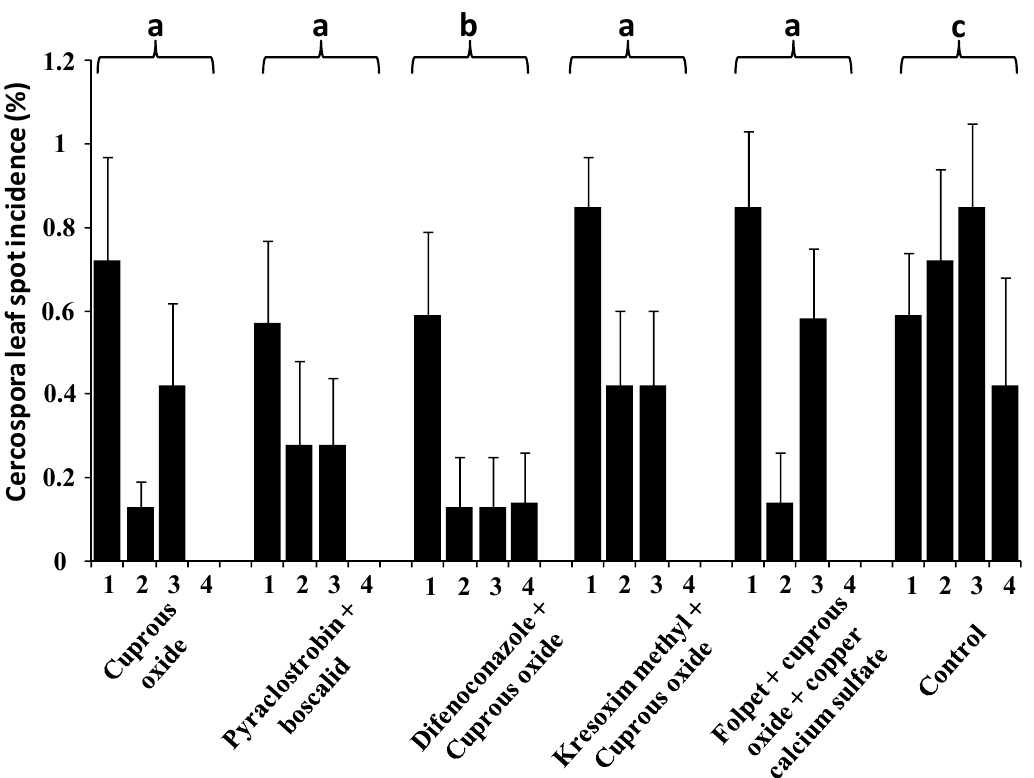
Figure 3. Incidence of cercospora leaf spot of olive (CLSO) at the four sampling times (1 = May 2003, 2 = November 2003, 3 = March 2004 and 4 = May 2004) in olive trees treated with different fungicides. Three applications per treatment were performed in March, May and October. Columns represent the average of 14 olive trees. Vertical bars are the standard error (SE) of the means. Fungicides with the same letter did not show differences in the reduction in CLSO incidence among the first and the last evaluation according to Fisher´s protected LSD test at P = 0.05.